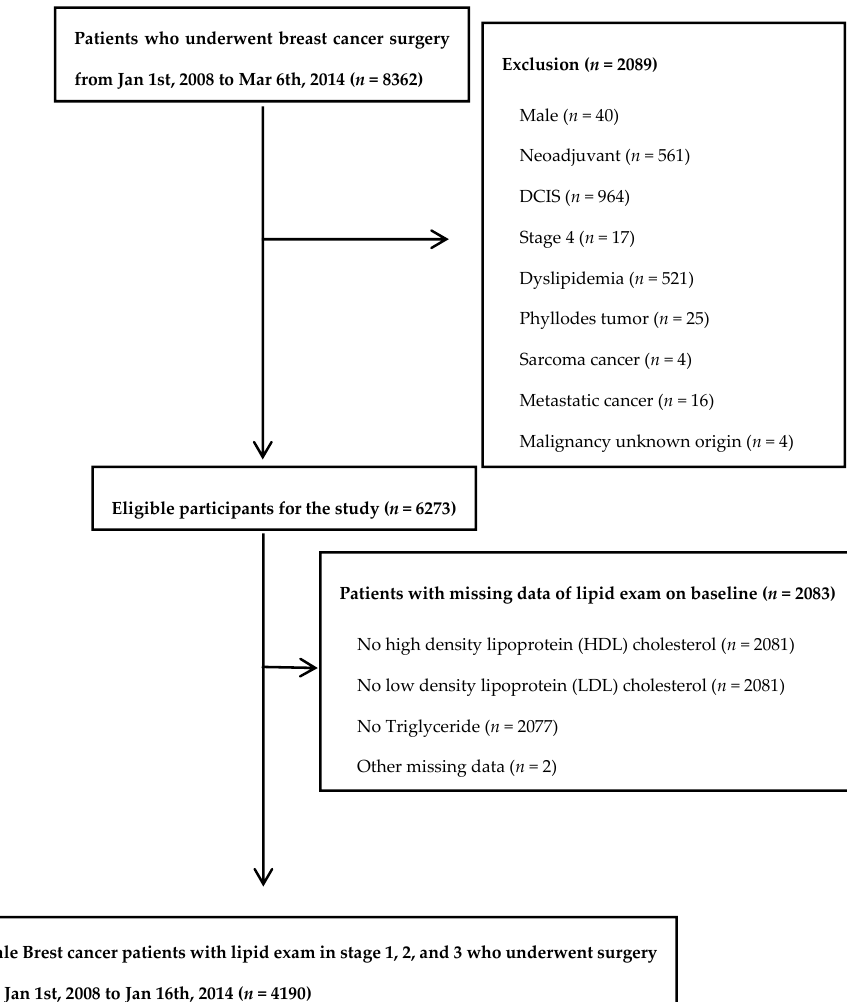
Figure 1. Flow chart of population.